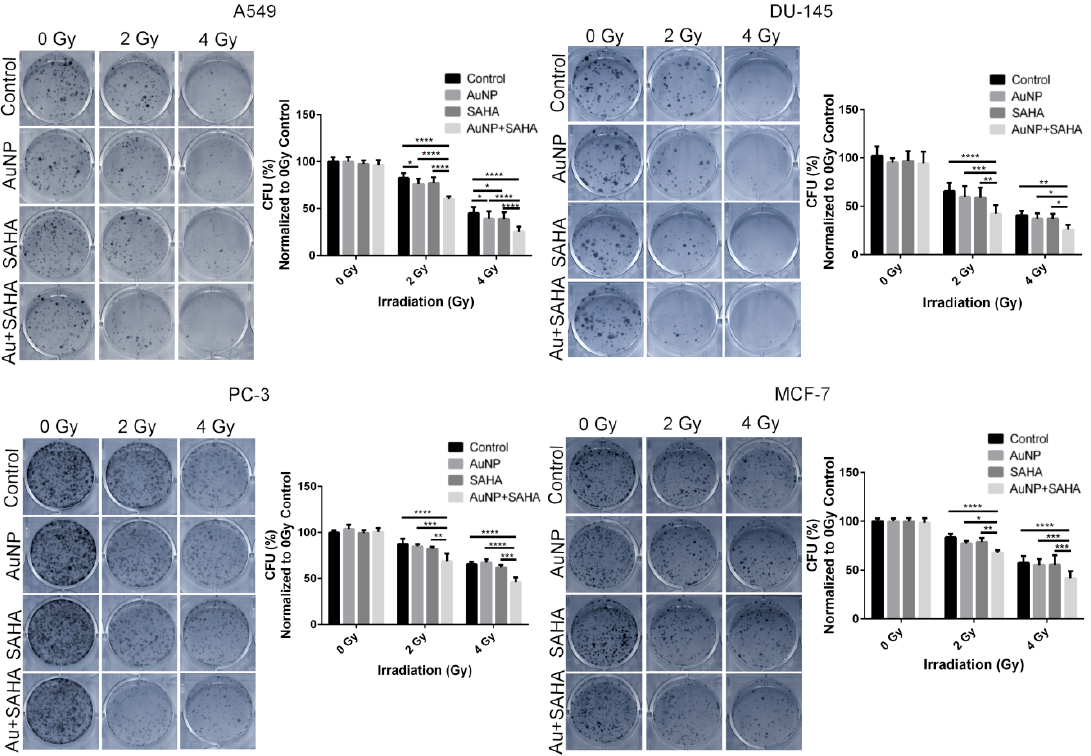
Figure 8. Radiosensitizing effect of AuNP and SAHA double treatments on cancer cells growing in 3D. The combination of AuNPs and SAHA significantly decreased the colony forming capability of A549, DU-145, PC-3 and MCF-7 cells in 3D cell cultures after 2 and 4 Gy irradiation compared to the control and to the individual treatments. (* p value < 0.05; ** p value < 0.01; *** p value < 0.001; **** p value < 0.0001; two-way ANOVA Tukey’s multiple comparisons test).